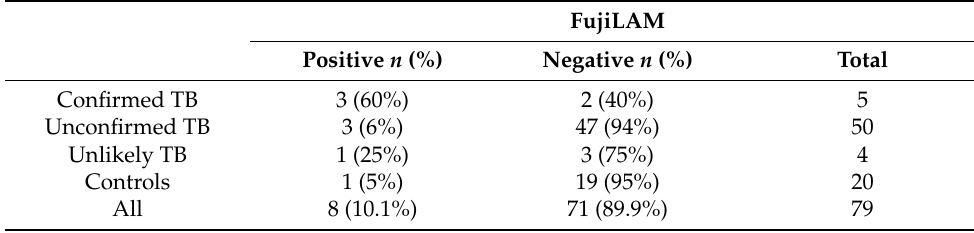
Table 2. FujiLAM results by study